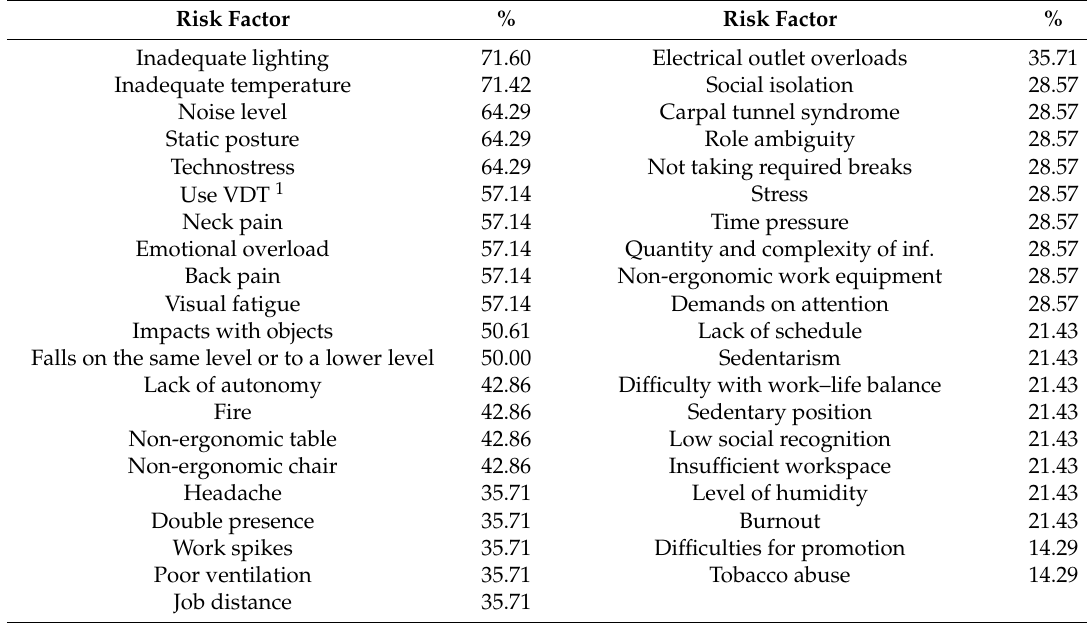
Table 2. Assignation percentage by experts for every risk factor.